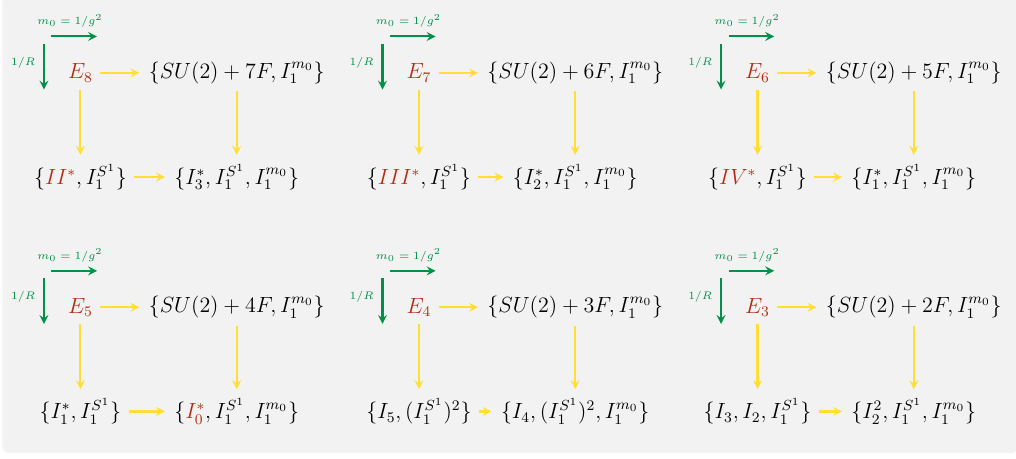
Figure 2 . Graphical depiction of the behavior of the 5d rank-1 E n theories under both circle compactification (vertical direction) and mass deformation (horizontal direction) associated to 5d gauge coupling. Superconformal theories are labeled in